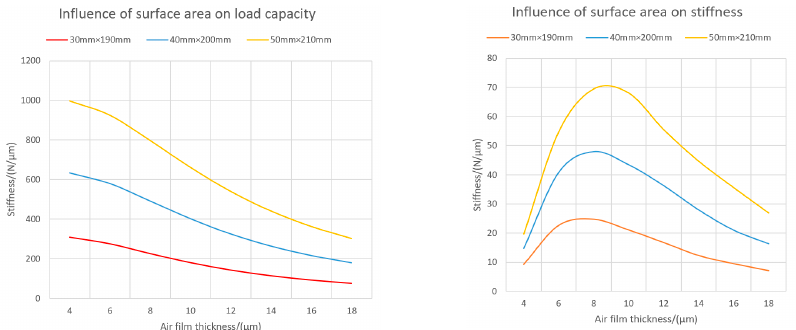
Figure 9. Load capacity and stiffness under different air film sizes.